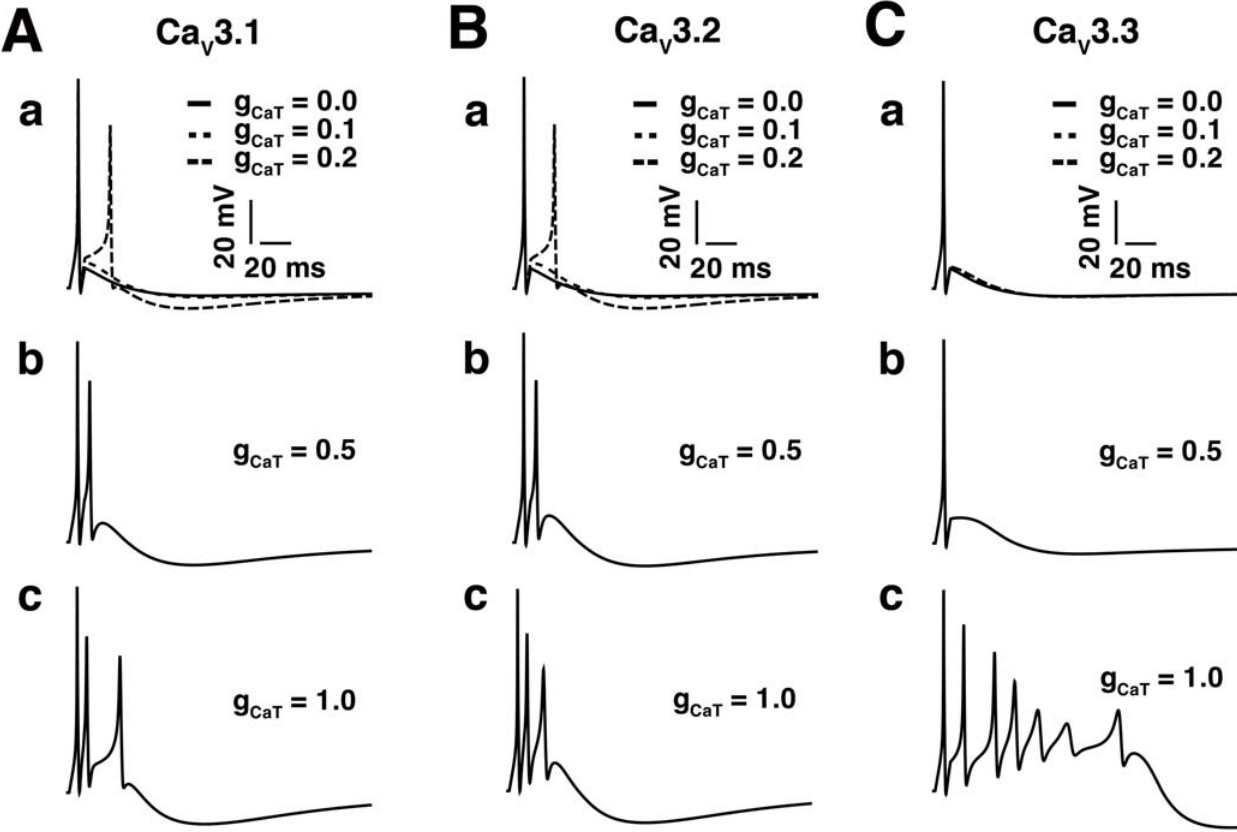
Figure 6. Effects of varying g CaT for each T-type Ca 2 + channel subtype. In each panel, the stimulus was 0.1 nA for 10 ms. Panels (a), (b), and (c) in columns A, B, and C show the effects of varying g CaT for Ca V 3.1, Ca V 3.2, and Ca V 3.3, respectively. (A) The effects of varying g CaT for Ca V 3.1: increasing g CaT increases afterdepolarizing potential (ADP) and promotes bursting (in 6Aa, solid line for g CaT =0 versus short broken lines for 0.1 mS/ cm 2 ). With increasing g CaT , a burst emerges as shown in Figures 6Aa (long broken line) to 6Ac. (B) Similar results were obtained when Ca V 3.2 channels were expressed alone. (C) The effects of varying g CaT for Ca V 3.3: the transition between a single spike (panel b for g CaT= 0.5 mS/cm 2 ) and a burst (panel c for g CaT= 1.0 mS/cm 2 ) is abrupt. move the fast subsystem in and out of the repetitive spiking regime. The region above the nullcline corresponds to a region of repetitive firing and the region below the nullcline is where the system is silent. The direction of the trajectory is indicated with arrows.